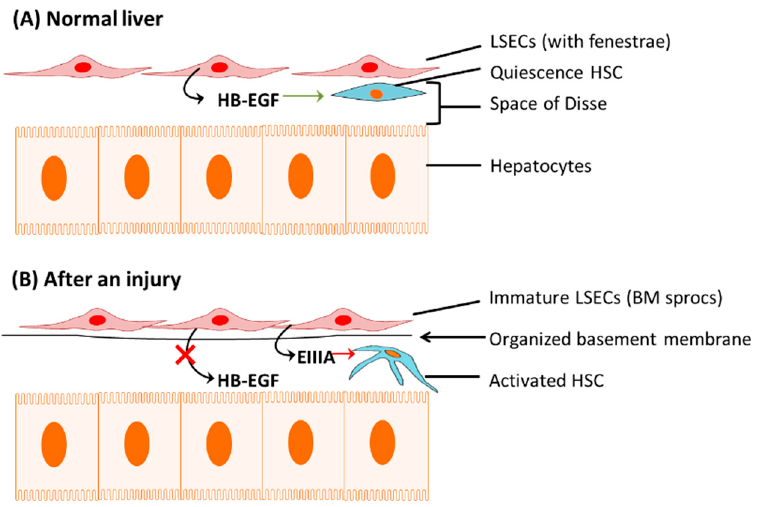
Figure 1. Reduced HB-EGF levels and the expression of fibronectin isoform EIIIA by immature LSECs, which activate HSCs [1].